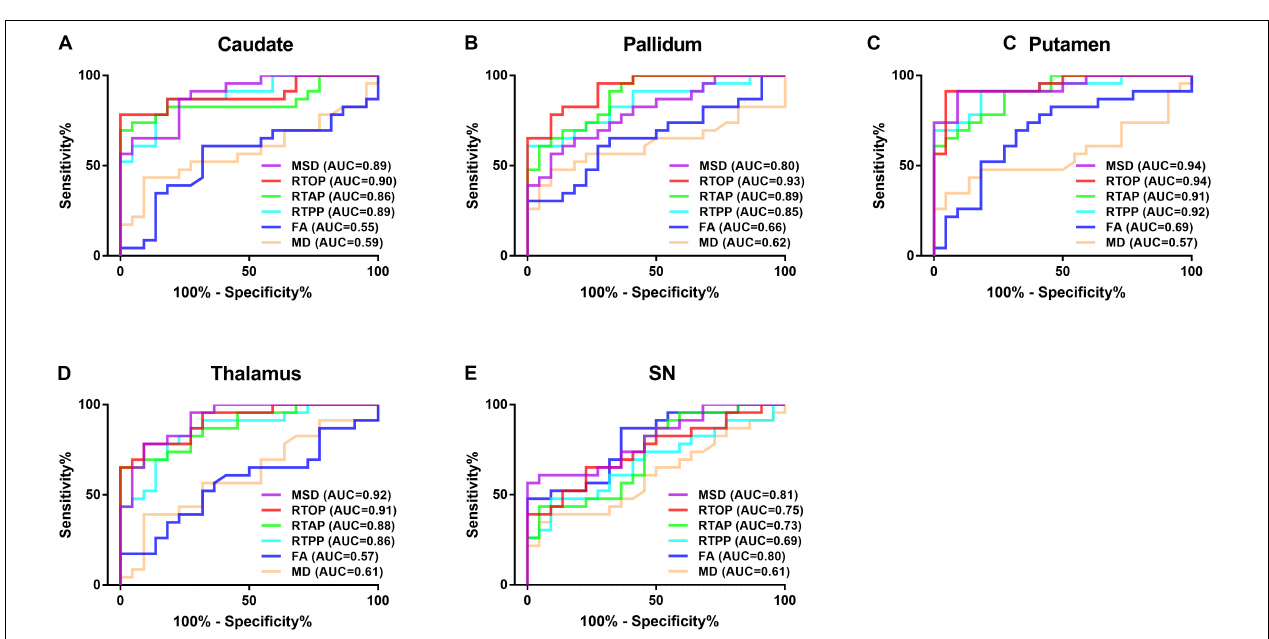
FIGURE 5 | The Receiver operating characteristic (ROC) analysis of MAP MRI and DTI parameters in the bilateral caudate (A) , pallidum (B) , putamen (C) , thalamus (D) and SN (E) . MAP MRI showed higher diagnostic performances than DTI in distinguishing PD patients from controls. AUC: the area under the curve.